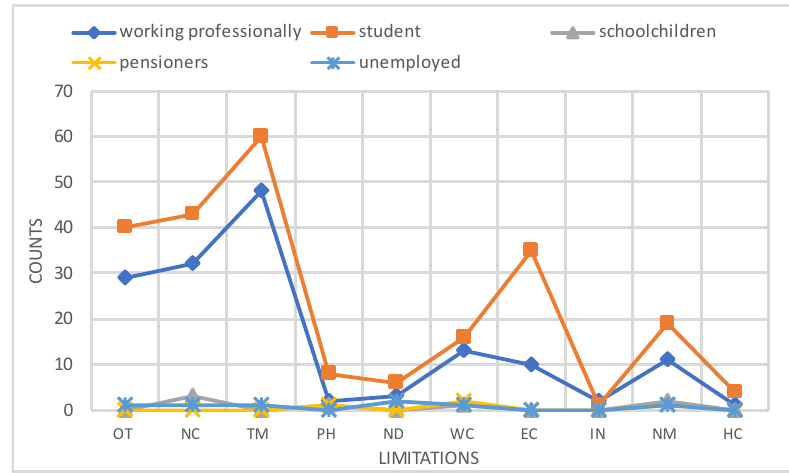
Figure 30. A graph of the interactions between the limitations in the accessibility of tram transport and the respondents’ occupation.